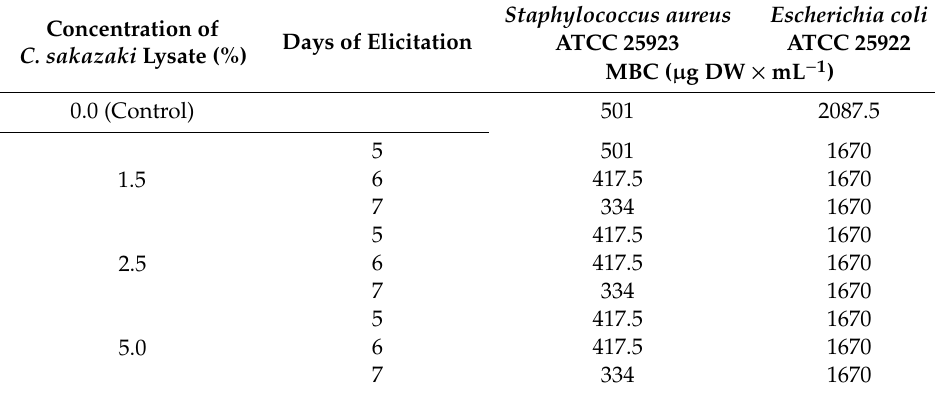
Table 1. Minimal bactericidal concentration (MBC) of S. aureus and E. coli after treatment with extracts of Dionaea muscipula plants after five, six and seven days of elicitation with Cronobacter sakazaki lysate in di ff erent